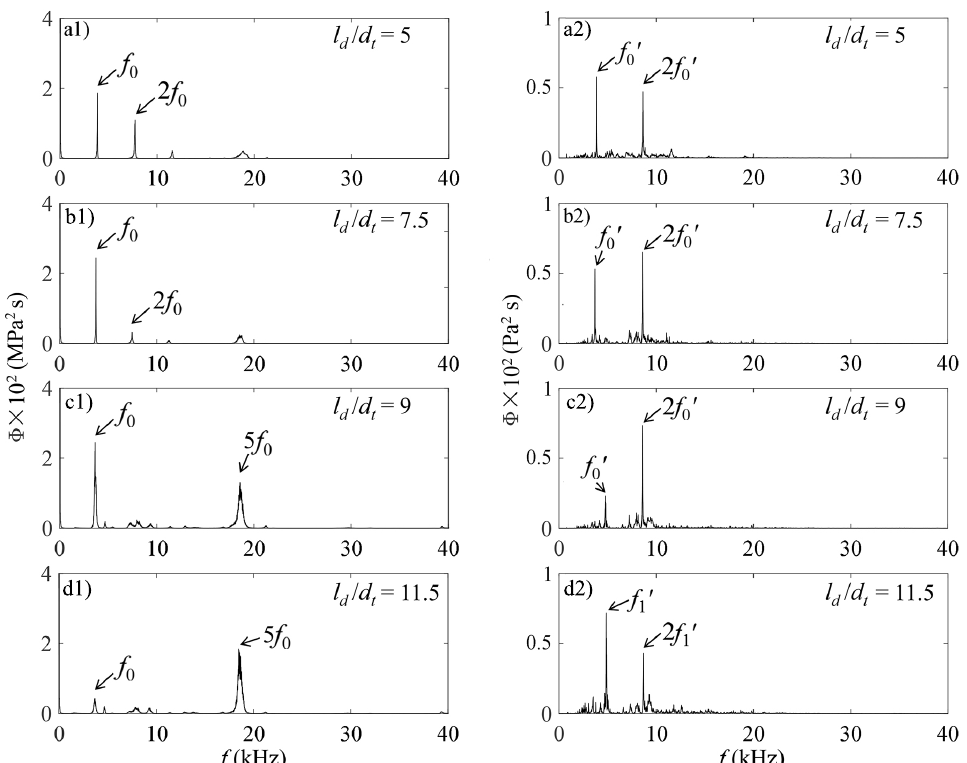
Figure 13. Spectra of the self-resonating oscillations (left column) and the cavitation noise (right column) at α = 15 ◦ . ( a1 , a2 ) l d / d t = 5; ( b1 , b2 ) l d / d t = 7.5; ( c1 , c2 ) l d / d t = 9; ( d1 , d2 ) l d / d t = 11.5.